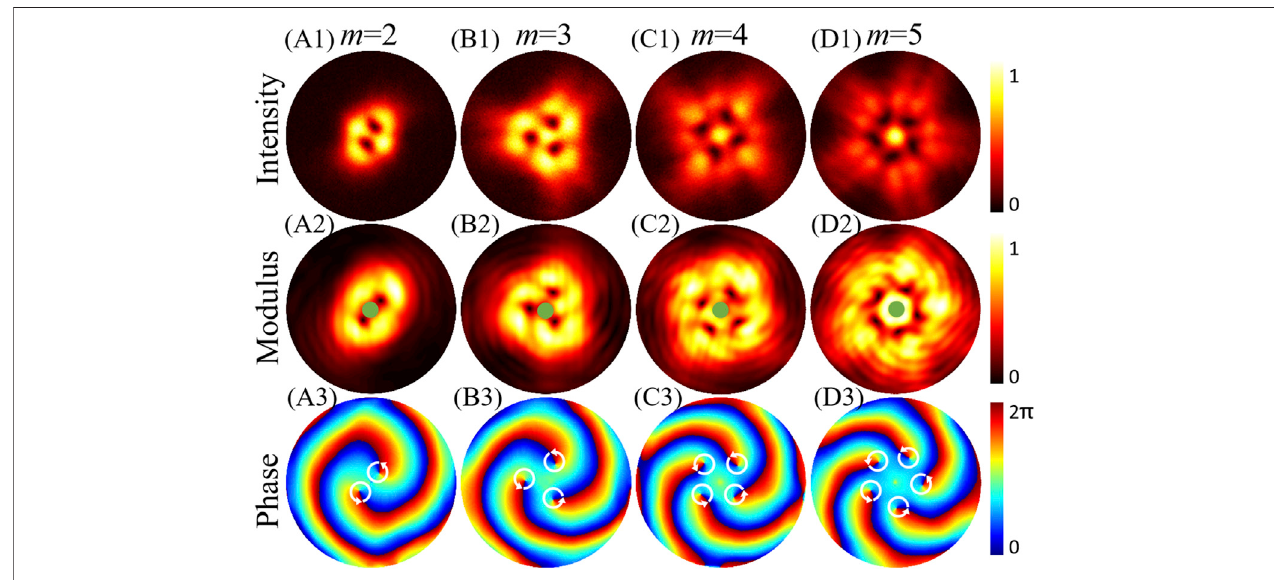
FIGURE 9 | Experimental intensity on CCD 1 and CSD distributions of the PC-PEPV beam with high spatial coherence width ( σ (cid:1) 20 mm). (A1 – D1) are intensity patterns, (A2 – D2) are modulus of the CSD function, and (A3 – D3) are phase patterns of the CSD function.